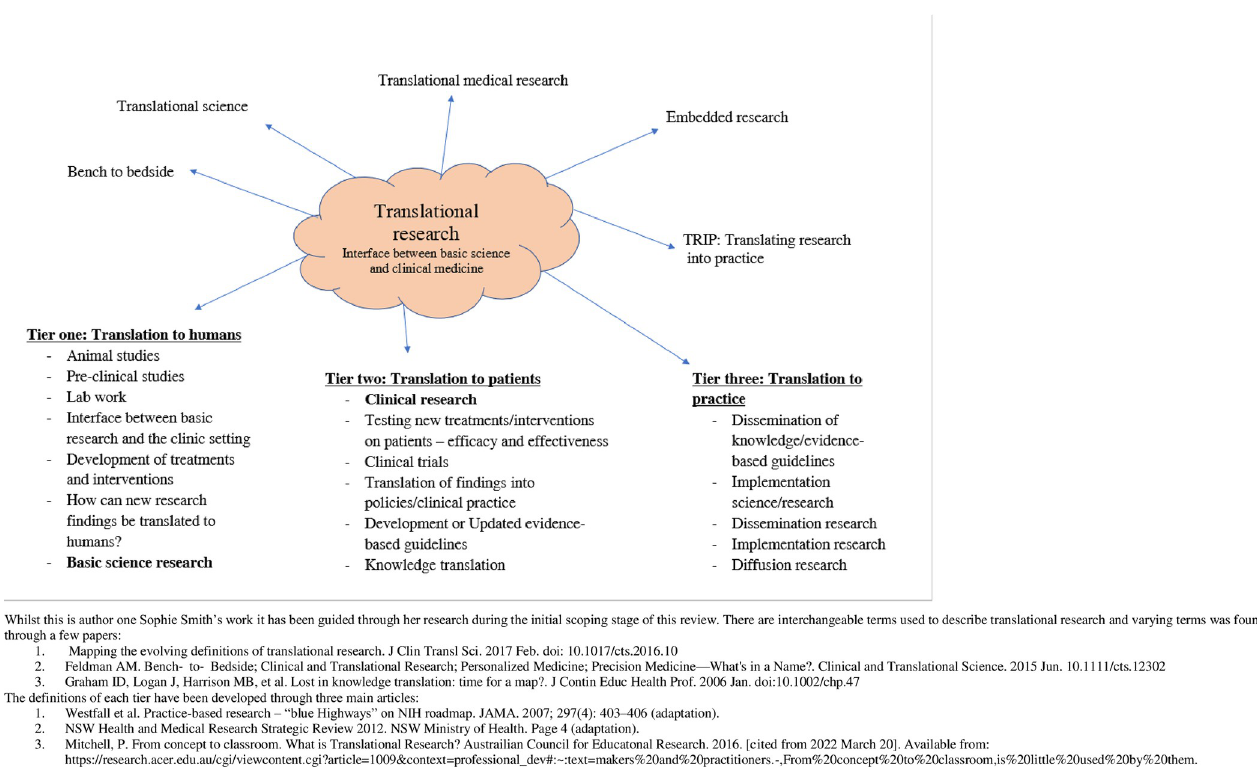
Fig 3. Definition of translational research (authors own